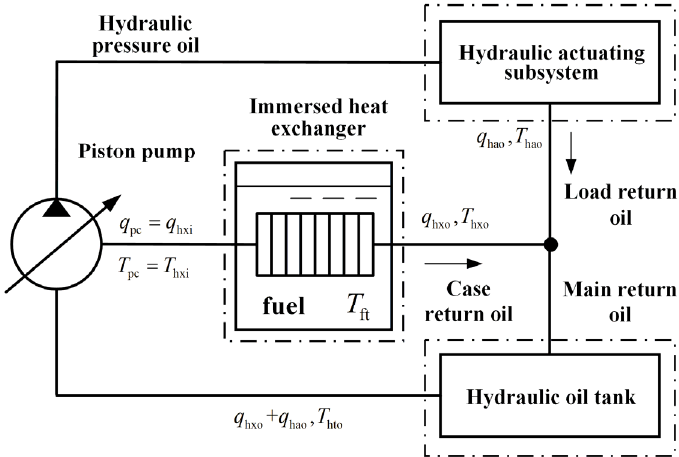
Figure 6. Thermal modeling mechanism of hydraulic oil tank.